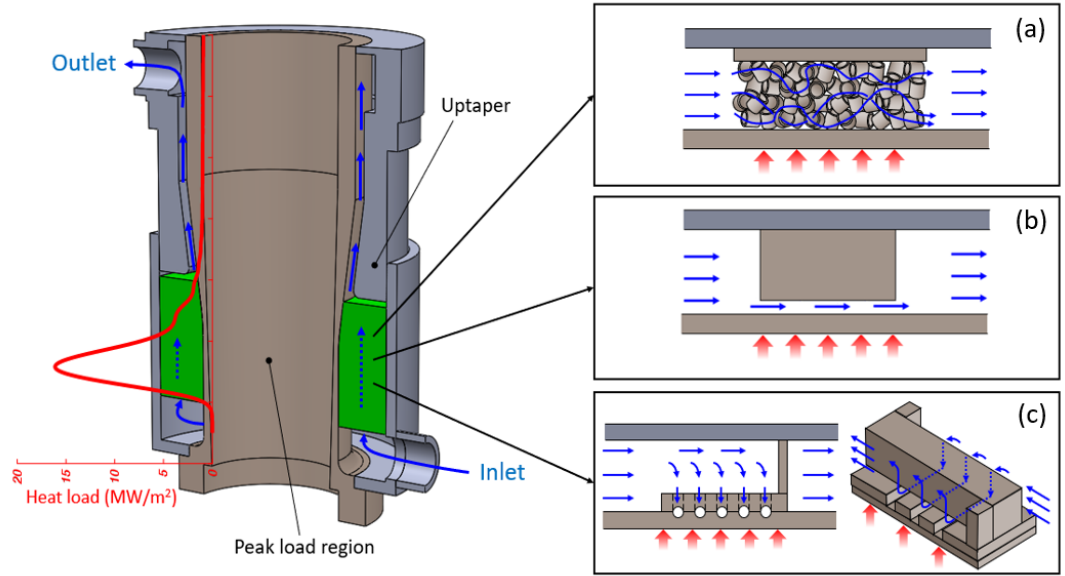
Figure 2. Schematic view of the gyrotron resonator, with different cooling strategies: ( a ) Raschig rings, ( b ) longitudinal mini-channels, ( c ) azimuthal micro-channels. The fluid path is highlighted with blue arrows. An example of a typical heat load distribution along the cavity axis is also reported in red in the left sketch.